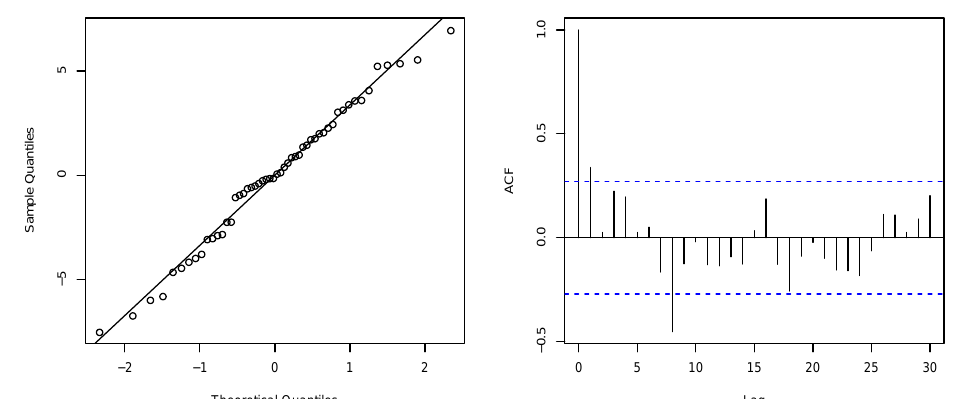
Figure A2. Residual diagnostics.